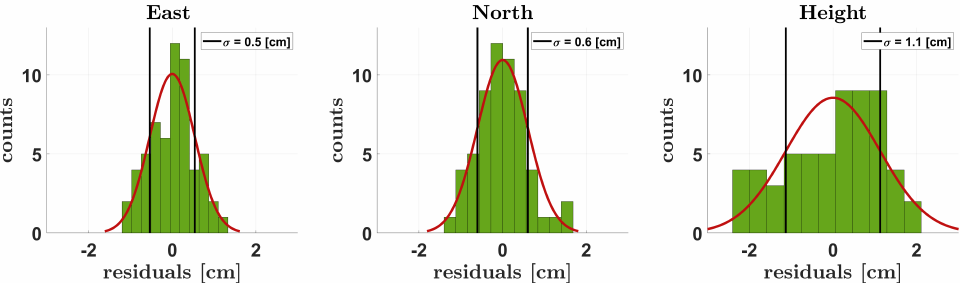
Figure 6. Estimated georeferencing precision for east, north, and height. Histograms in green are the residuals to the mean targets center coordinates in Figure 5a. In red: approximation of the normal distribution. Black lines correspond to estimated standard